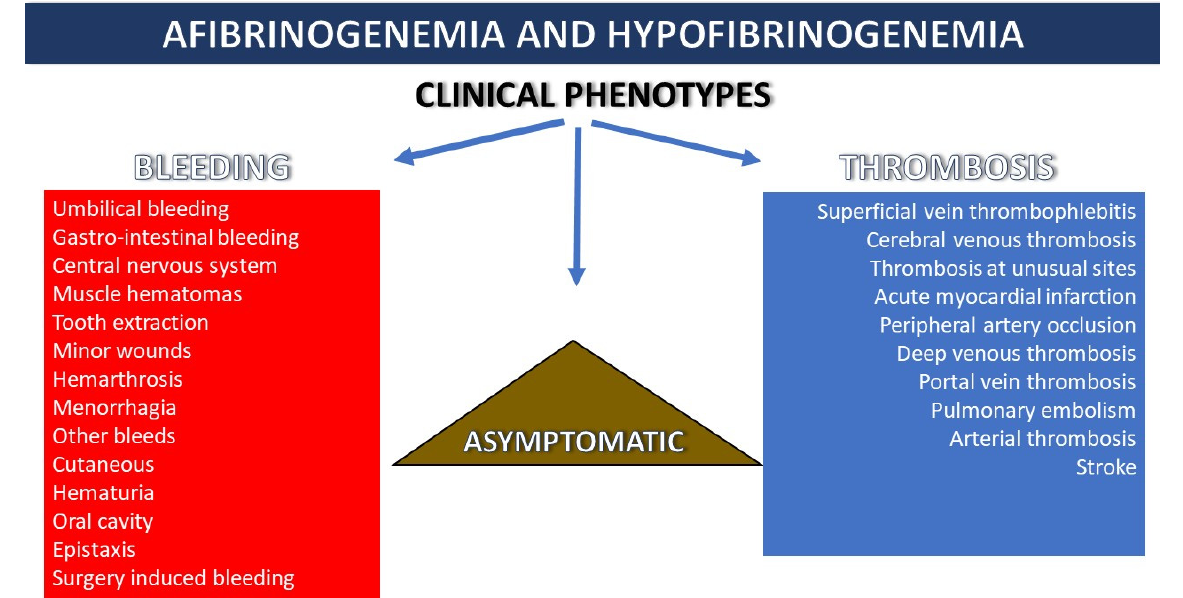
Figure 2. Characterization of clinical phenotype in patients with quantitative fibrinogen disorders.